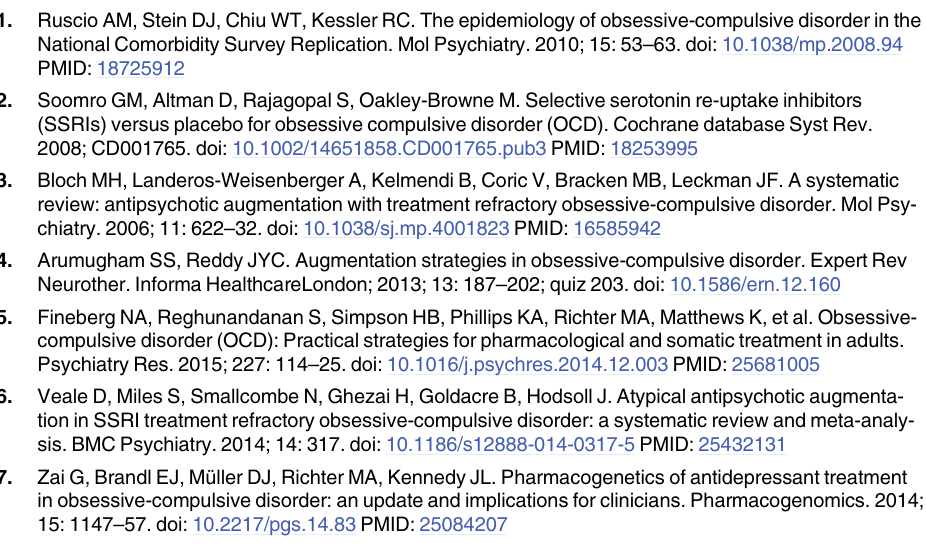
S1 Table. Association results of GWAS for the SSRI treatment response in OCD (P values < 1.0 x 10 − 3